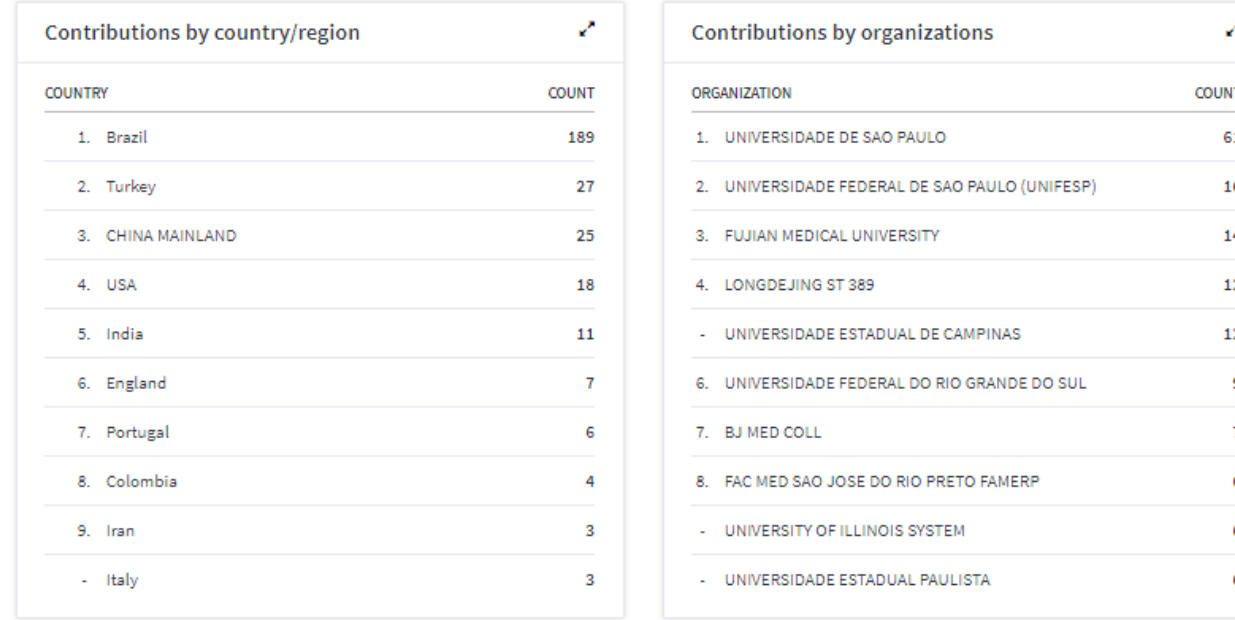
Fig. 2 - Division of BJCVS citations according to countries and institutions of